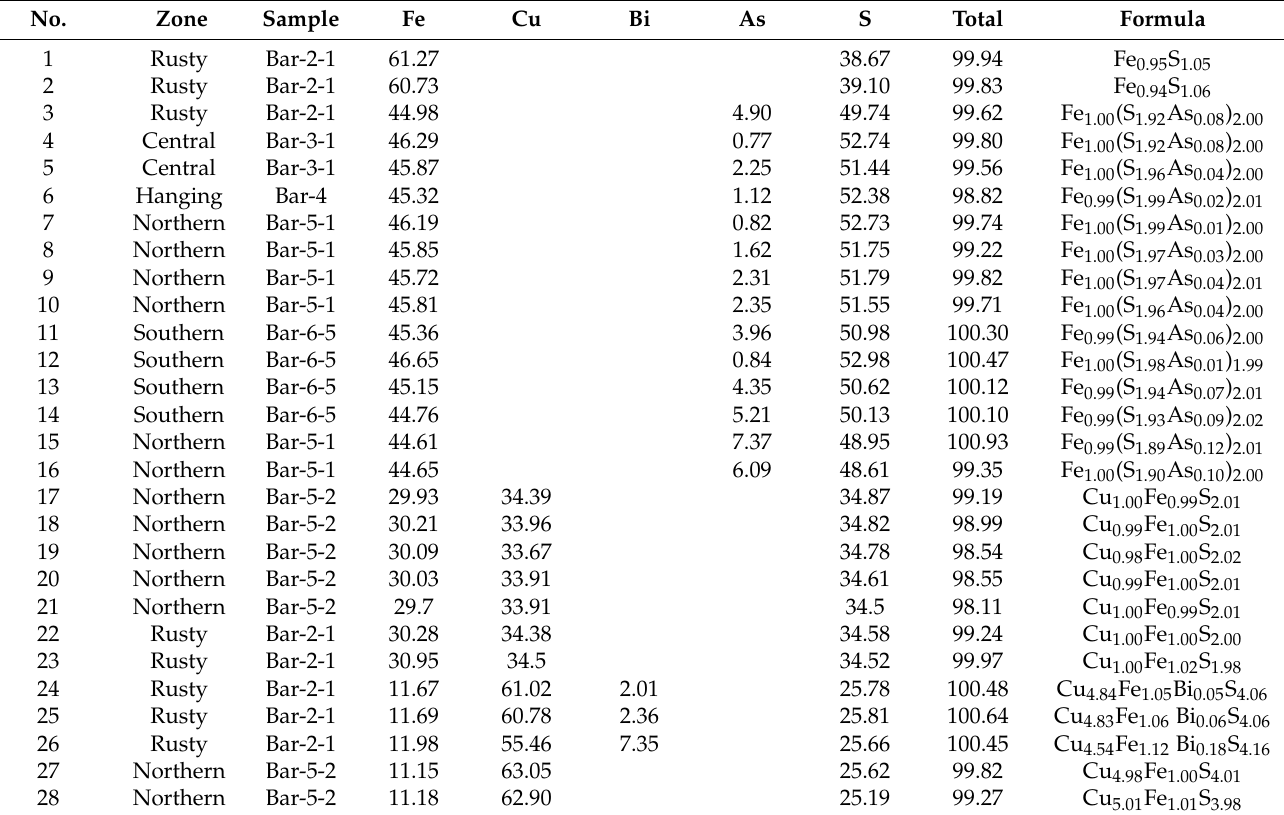
Table 1. Composition of the main sulfides of the Baranyevskoe deposit, wt. %.